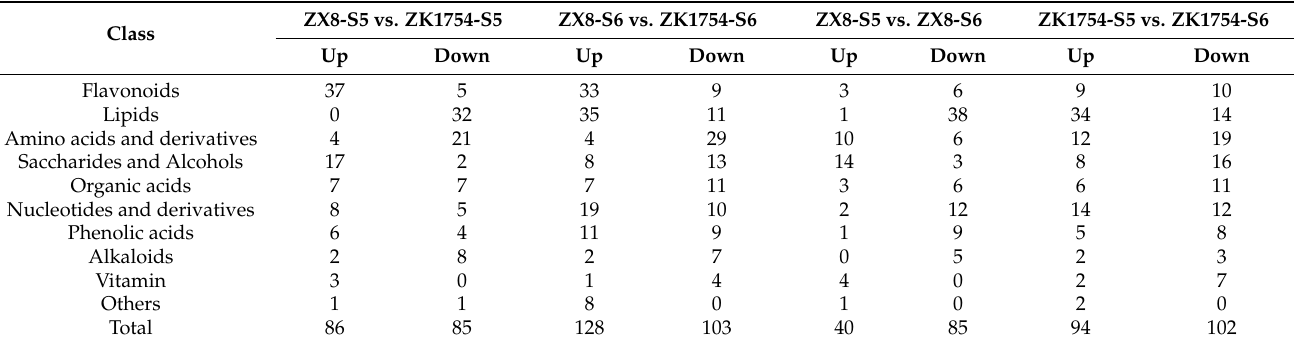
The classification and differential accumulation metabolites (DAMs) numbers in ZX8 vs.